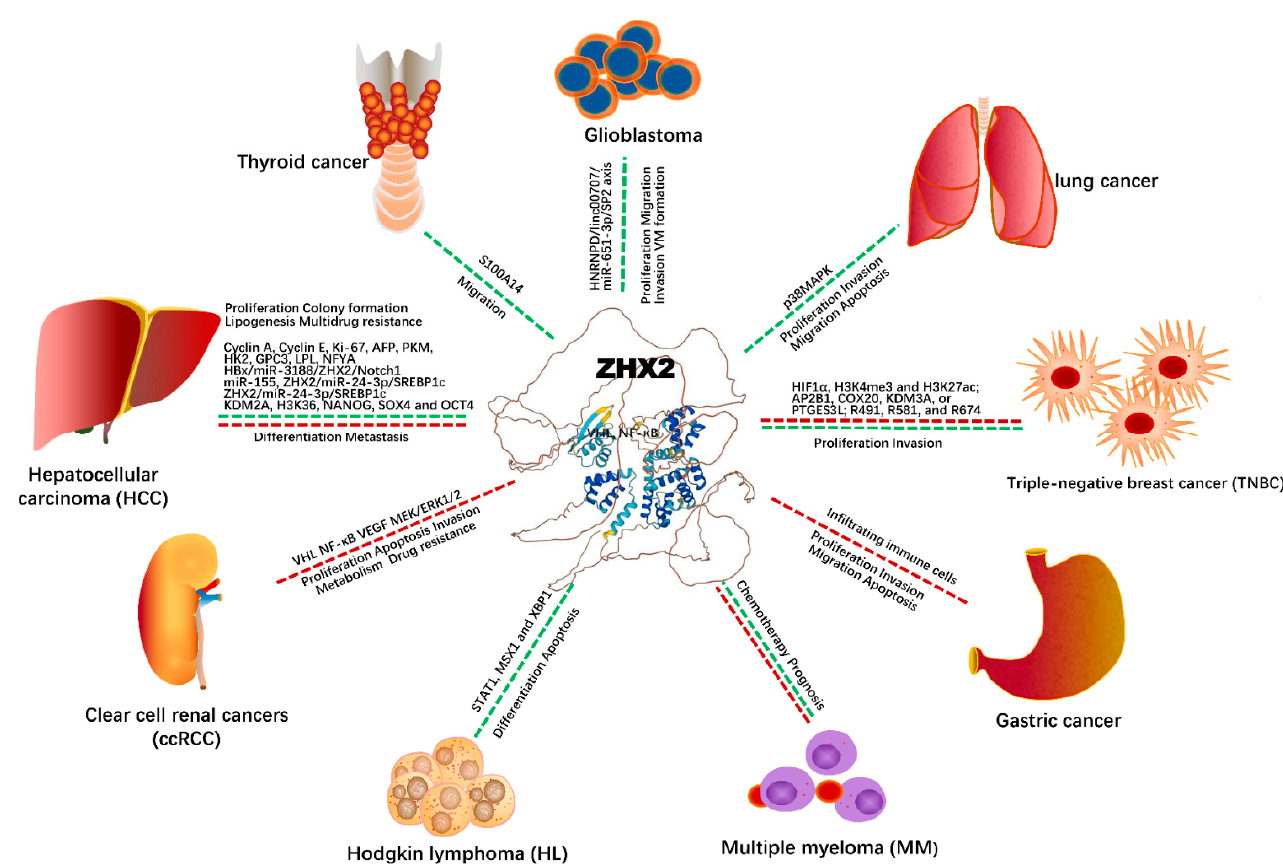
Figure 2. ZHX2 and cancers: biological functions and potential signaling networking.